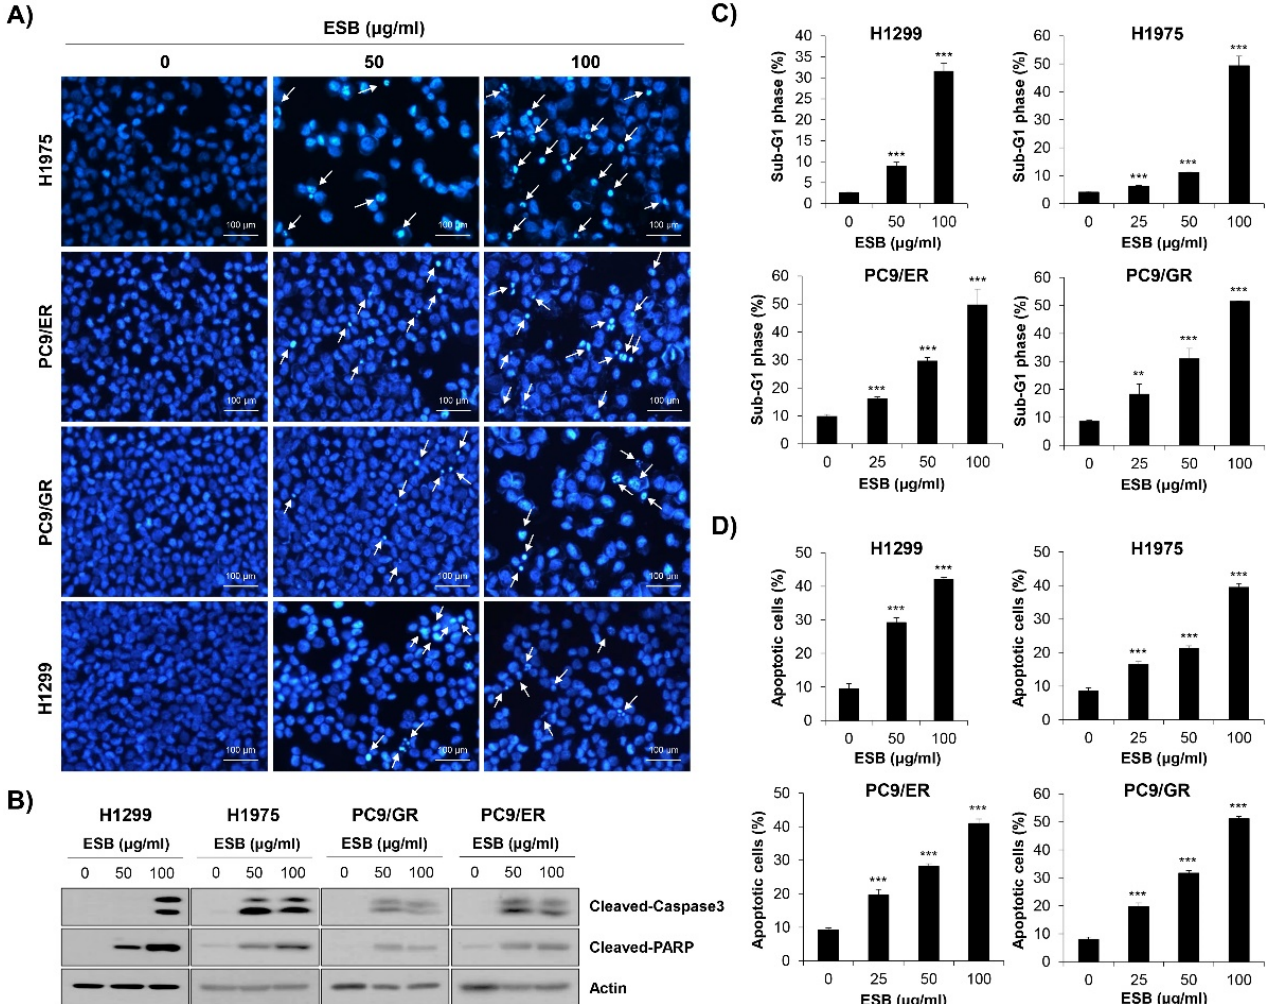
Figure 5. Induction of apoptosis by ESB in EGFR TKI-resistant human NSCLC cell lines. H1299 ( EGFR wildtype; EGFR TKI-resistant), H1975 (acquired TKI-resistant), PC9/ER (acquired erlotinib-resistant), and PC9/GR (acquired gefitinib-resistant) human NSCLC cell lines were treated with different concentrations of ESB for 72 h. ( A ) The nuclear morphology visualized by DAPI staining was observed under a fluorescence microscope at × 200 magnification. The white arrows indicate apoptotic cells. The representative images of three independent experiments are shown. ( B ) The expression of cleaved caspase-3 and cleaved PAPR was detected by Western blot analysis. Actin was used as a loading control. ( C , D ) Cell cycle distribution ( C ) and annexin V-PI-double stained cells ( D ) were analyzed by flow cytometry. The sub-G1 DNA content ( C ) and percentage of annexin V+ cells ( D ) were measured by CellQuest software. The data are expressed as the mean ± SD of three independent experiments. Significance was determined by the Student’s t -test (** p < 0.01, *** p < 0.001 vs. untreated controls). ESB, ethanol extract of the root of Scutellaria baicalensis ; NSCLC, non-small-cell lung cancer; EGFR TKI, Epidermal growth factor receptor tyrosine kinase inhibitor; STAT3, signal transducer and activator of transcription 3; SD, standard deviation.